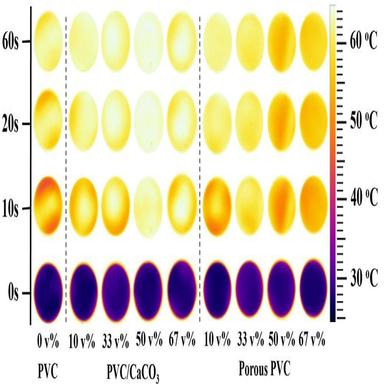
Infrared photography of PVC films, PVC/CaCO3 composite films and PVC porous films.